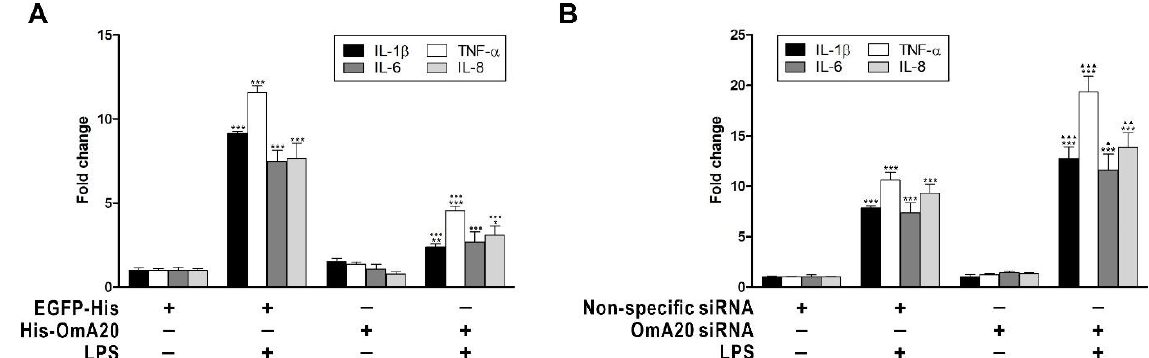
Figure 5. Effect of OmA20 overexpression or silencing on the expression of downstream target genes of MAPKs and NF- κB in RTH -149 cells stimulated with LPS. RTH-149 cells, transfected with His-OmA20, EGFP-His ( A ), OmA20 siRNA, or non-specific siRNA ( B ) for 48 h, were stimulated with LPS (10 μg /mL) for 12 h. Then, the expression of IL- 1β, TNF - α, IL - 6, and IL-8 was analyzed by qRT-PCR. * p < 0.05, ** p < 0.01, *** p < 0.001 unstimulated control vs. LPS-stimulated cells; ●●● p < 0.001 EGFP-His vs. His-OmA20; ▲ p < 0.05, ▲▲ p < 0.01, ▲▲▲ p < 0.001 non-specific siRNA vs. OmA20 siRNA.